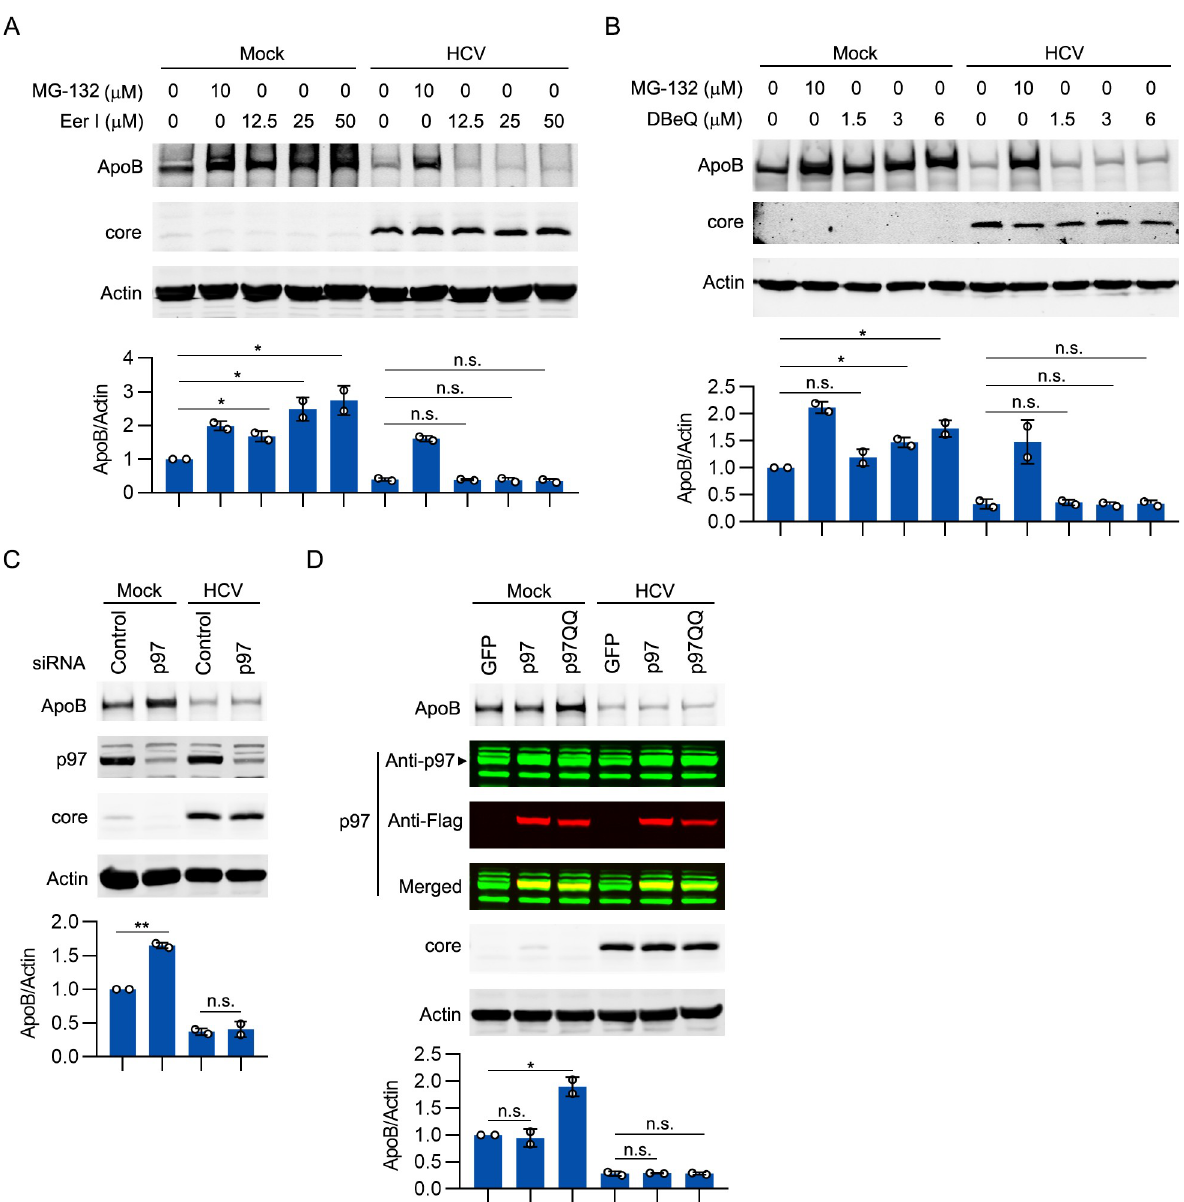
Fig 3. ERAD did not participate in HCV-induced ApoB degradation. (A, B) Huh-7 cells were infected with HCV (MOI = 1) for 4 days prior to treatment with MG-132, Eer I, or DBeQ for 12 hours. The levels of ApoB, Herp, and core were analyzed by western blotting. Actin was used as the loading control. (C) Huh-7 cells were infected with HCV (MOI = 1) for 48 hours prior to transfection with p97 siRNA for 2 days. The levels of ApoB, p97, and core were analyzed by western blotting. Actin was used as the loading control. (D) Huh-7 cells were infected with HCV (MOI = 1) for 2 days prior to transduction with GFP, a Flag-tagged wild type of p97, or a Flag-tagged dominant-negative p97 mutant (p97QQ) for 2 days. The levels of ApoB, p97, and core were analyzed by western blotting. Actin was used as the loading control. The data are presented the means ± SDs from densitometry analyses of n = 2 independent experiments, and representative gels from each specific assay are shown. The statistical significance was determined by unpaired two-sided Student’s t -tests. n.s., not significant. � P < 0.05. �� P <